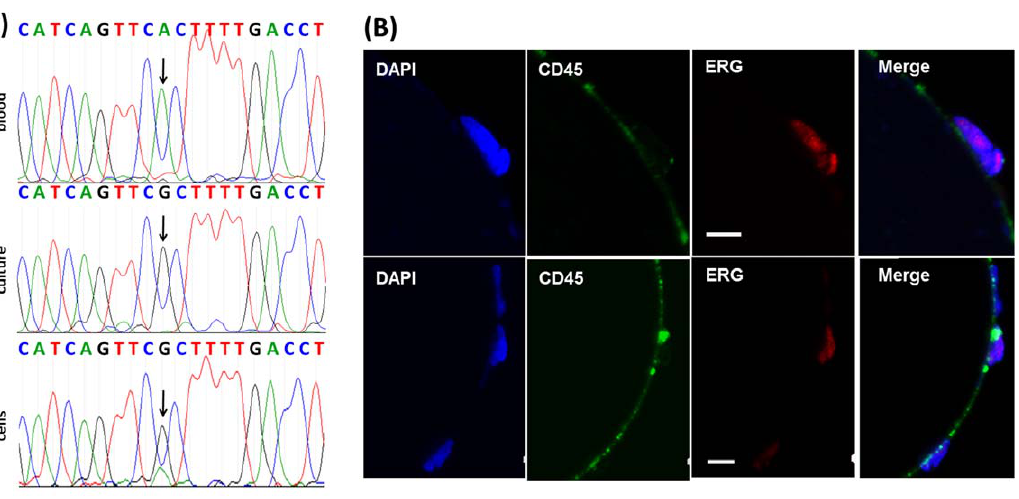
Figure 4. Functional characterization and detection of genetic alterations in GEDI-captured cells. (A) Captured cells exhibit high purity, enabling the identification of single point mutations. The T868A (ACT-GCT; Thr-Ala) AR single-point mutation is detected from RNA extracted from 50 C4-2 cells spiked into 1 ml of healthy-donor blood and captured by the GEDI device (third row, arrow). Sequencing results from 1 ml blood from the same healthy donor (top row) or from 50 C4-2 cells in culture (middle row) are also depicted. (B) The TMPRSS2:ERG fusion protein is detected in GEDI- captured CTCs from a CRPC patient. PSMA-captured CTCs were stained on the device with an anti-ERG antibody. Representative examples of three PSMA + /CD45 2 CTCs are shown, two of which are positive for ERG. Scale bars: 10